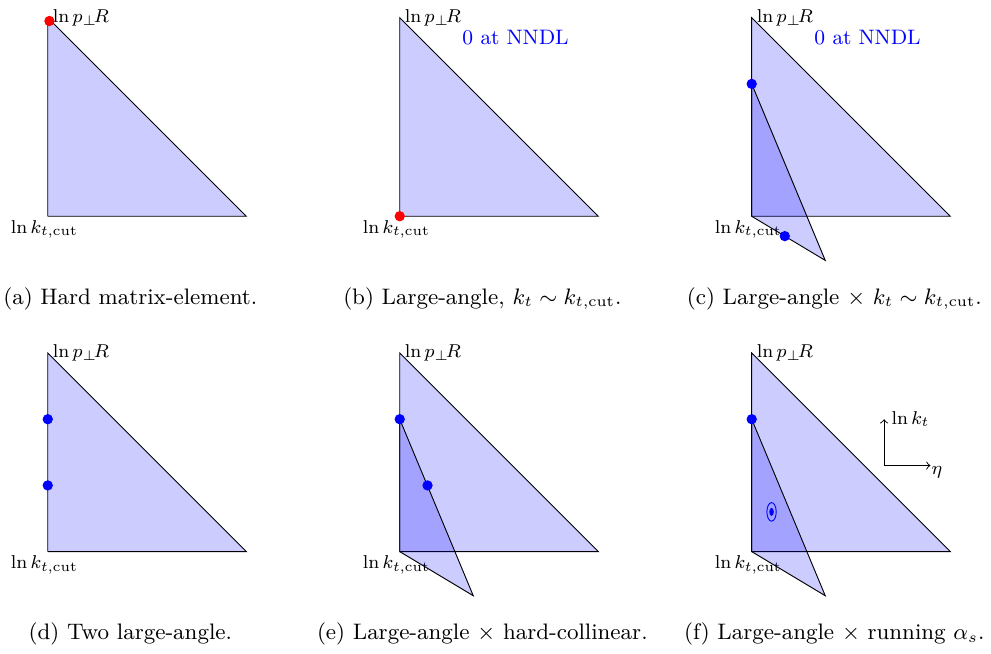
Figure 4 . Lund representation of the new configurations with respect to e + e − collisions that contribute to the multiplicity at